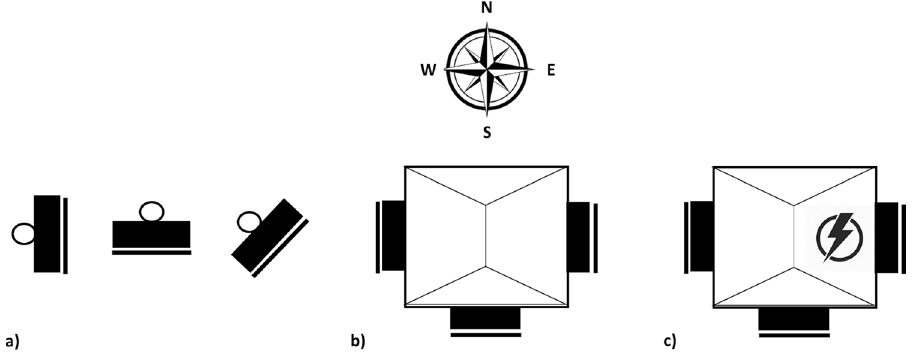
Figure 6. Schematic view of the experimental design for the orientation and mounting as tested for bat boxes on two sites in Quebec, in 2017 on ( a ) poles, ( b ) non-heated buildings and ( c ) heated